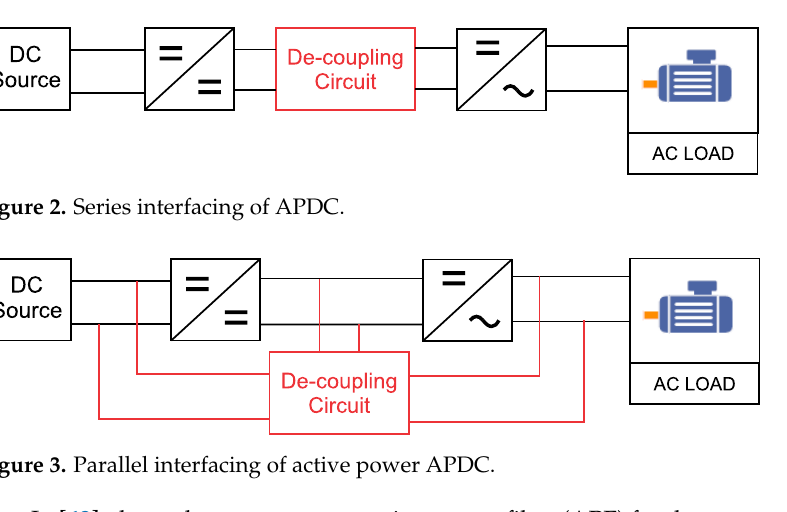
Figure 3. Parallel interfacing of active power